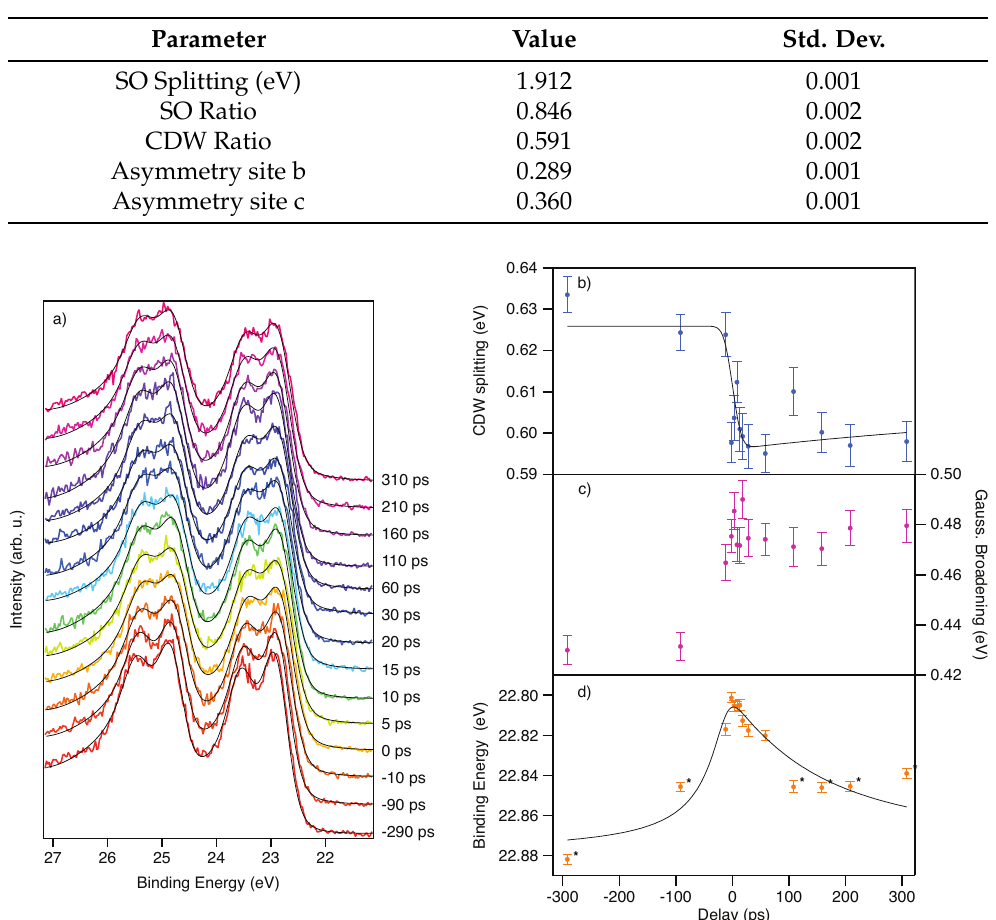
Figure 4. Picosecond pump-probe XPS Data of TaS 2 . Panel ( a ) shows the time-resolved spectra of the Ta 4f lines acquired at different pump-probe delays. The delay values have been adjusted to match the zero delay resulting from the fit. In the panels ( b – d ) we show the delay traces of the CDW splitting, the Gaussian broadening and the binding energy position, respectively. The data points marked with the asterisk (*) have ∼ 5 times less statistical weight (see text). The spectra have been acquired using a photon energy of 200 eV. Black lines represent the fit